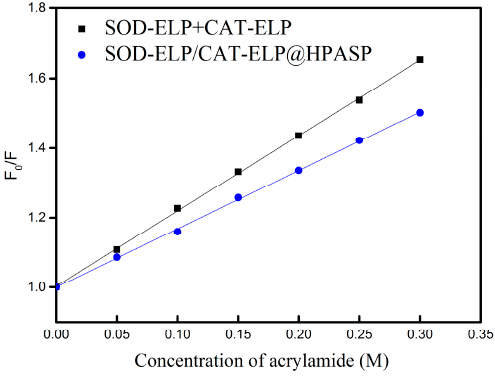
Figure 6. Stability comparison between the two mixed enzymes (SOD ‐ ELP+CAT ‐ ELP) and co ‐ immobilized enzymes (SOD ‐ ELP/CAT ‐